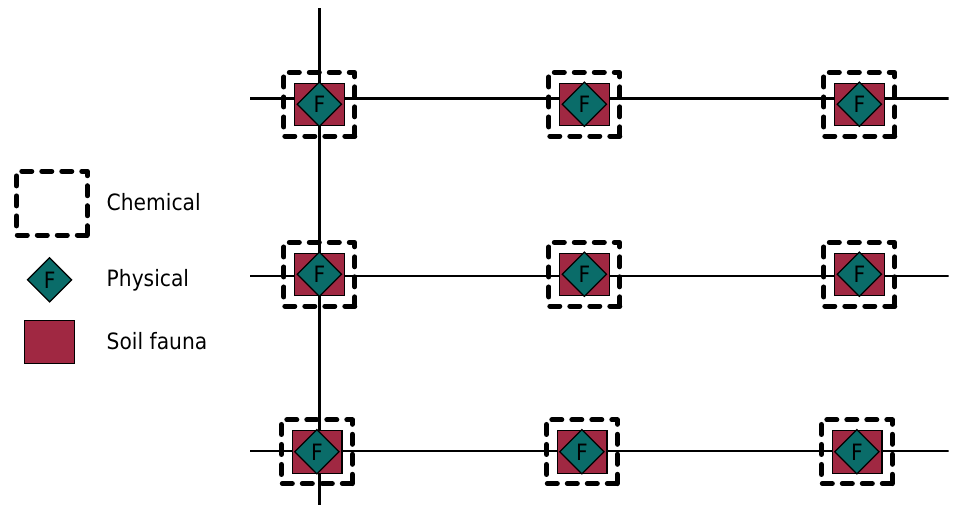
F Figure 1. Sampling grid used in the collection of samples for chemical and physical analysis and quantification of soil macrofauna.